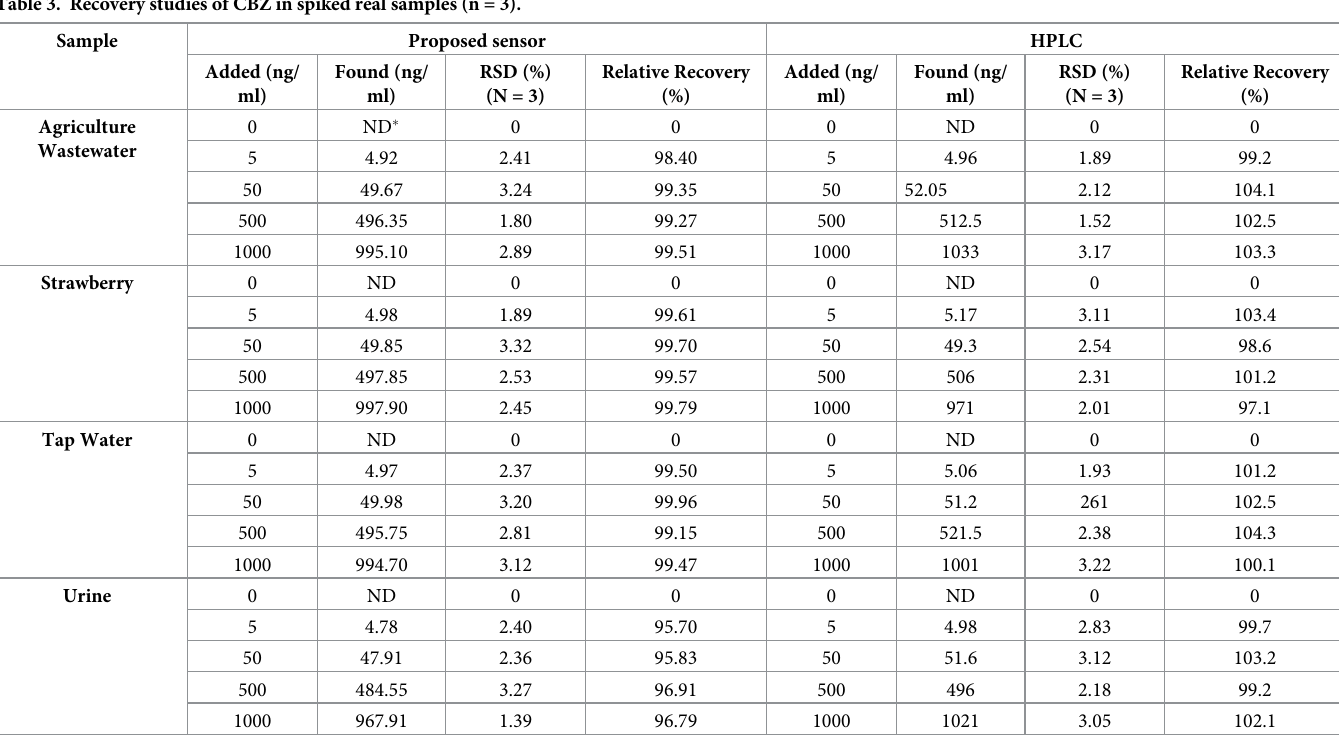
Table 3. Recovery studies of CBZ in spiked real samples (n =